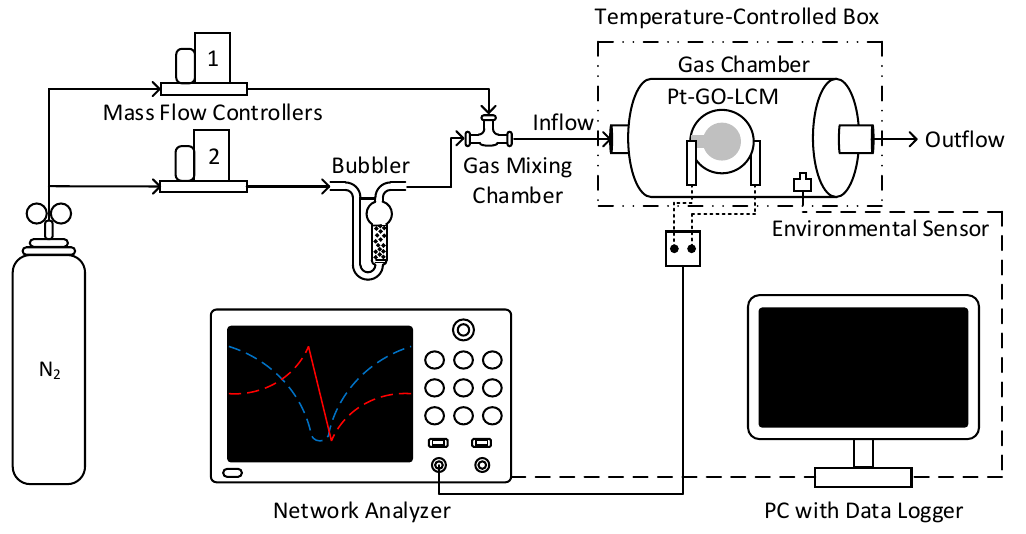
Figure 1. The automated gas sensing experimental setup.